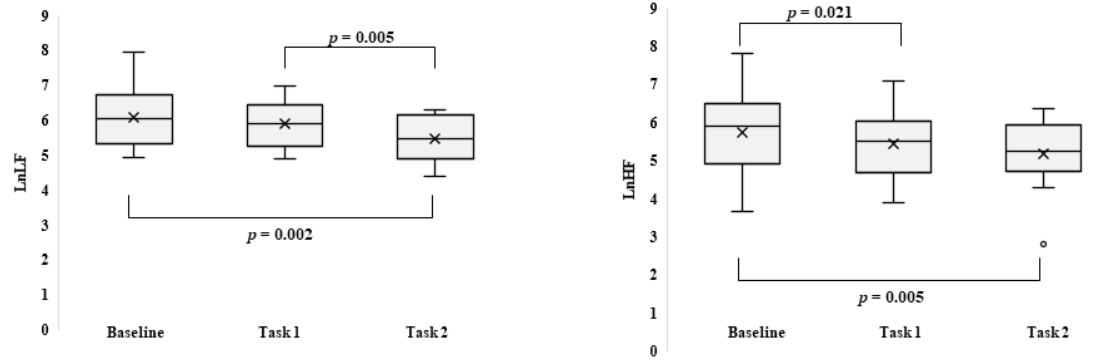
Figure 3. Boxplot of the natural logarithm of low-frequency power (left) and high-frequency power (right) in resting-state (baseline) and during tasks 1 and 2. In the graph, the extremities of the box represent the first (25th percentile) and the third (75th percentile) quartile, and the whiskers represent the minimum (0th percentile) and maximum (100th percentile). The central line is the median (50th percentile), the (x) is the mean, and the (o) upper or below the whiskers are the outliers.